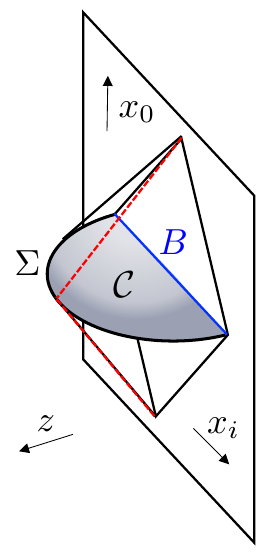
Figure 1 . Depiction of the causal diamond in AdS space anchored at the boundary. The red dotted line is the light signal from the boundary to a point in the